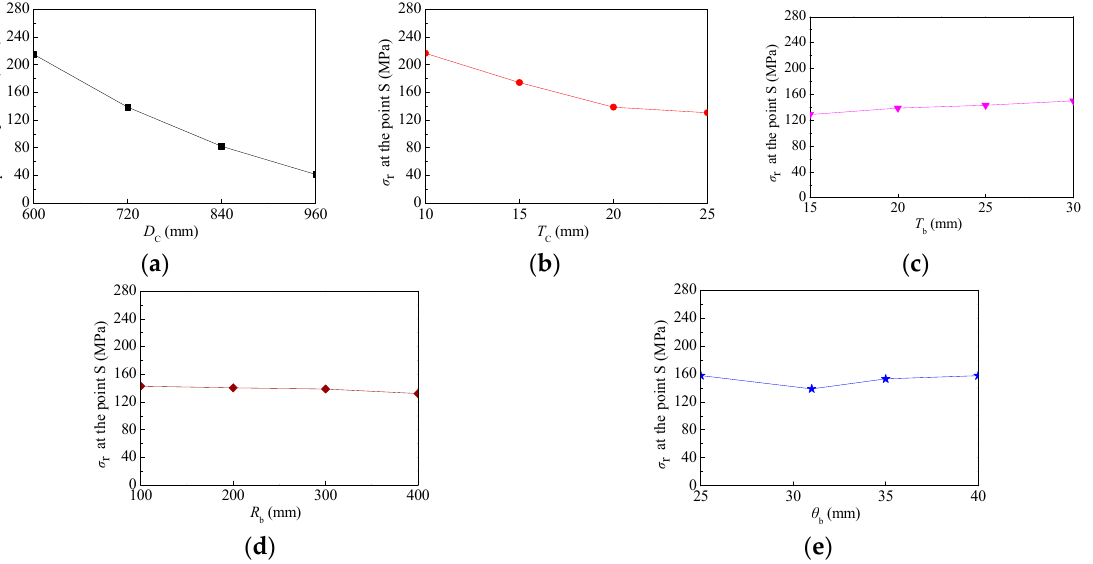
Figure 14. Sensitivity of hot spot stress at point S to parameters: ( a ) D c ; ( b ) T c ; ( c ) T b ; ( d ) R b ; and ( e ) θ b .